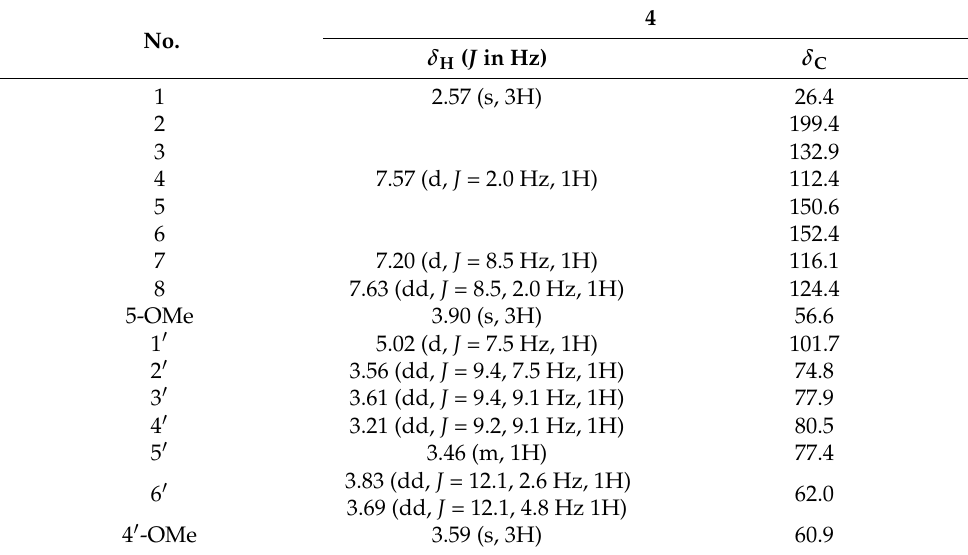
Table 2. The 1 H (400 MHz) and 13 C (100 MHz) NMR data of compound 4 in Methanol- d 4 . No.